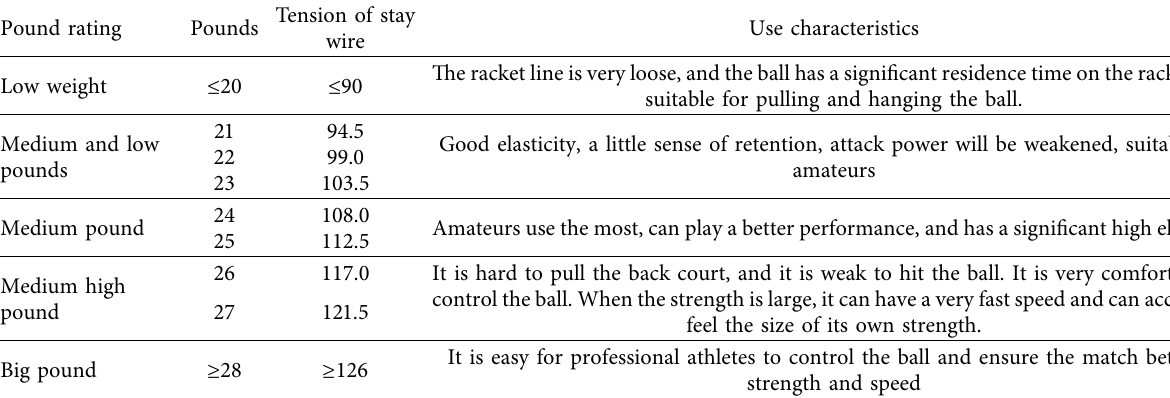
Table 3: The pull tension and use characteristics of badminton racket with different pounds.